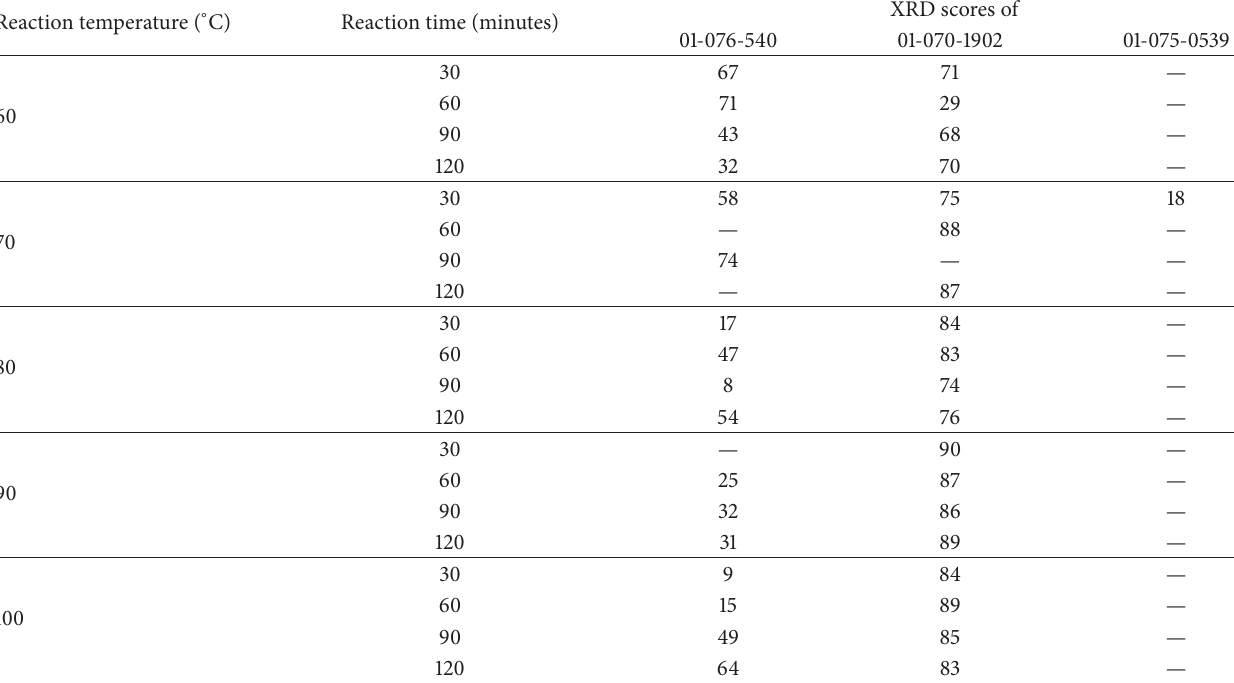
Table 2: XRD results of the synthesised magnesium borate